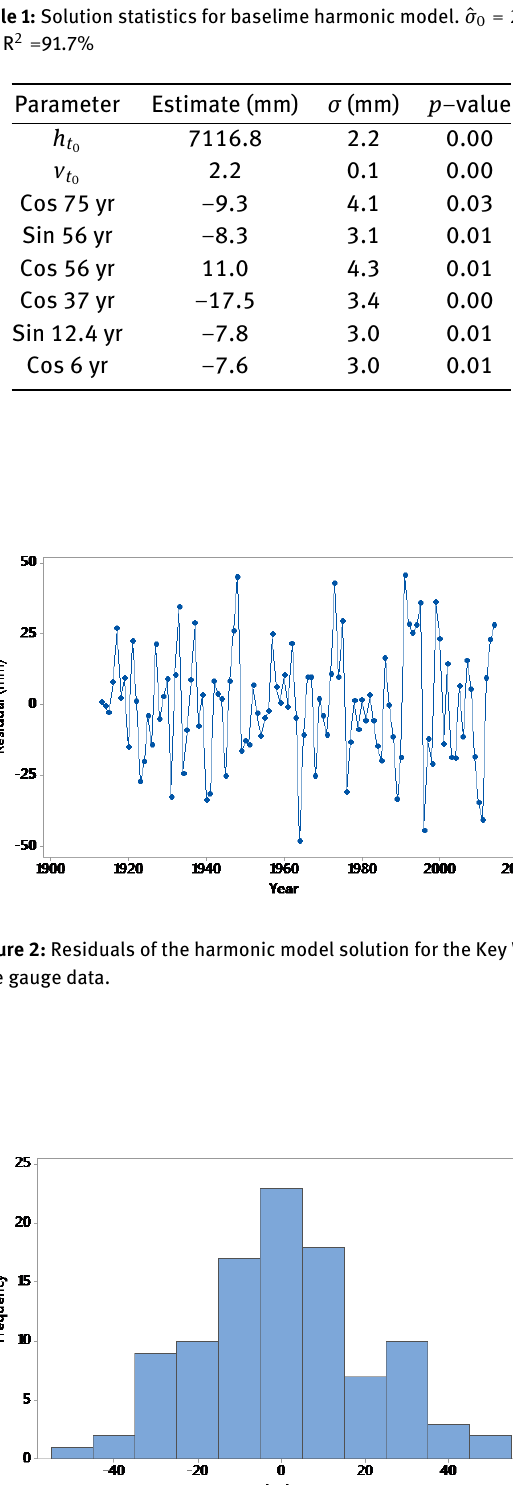
Table 1: Solution statistics for baselime harmonic model. ^ σ 0 = 21.0,